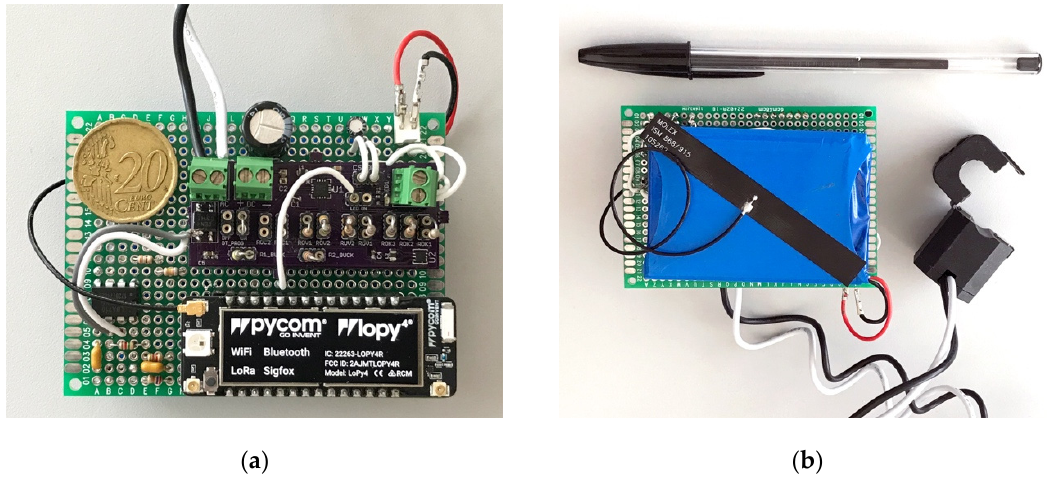
Figure 18. Picture of the prototype: ( a ) Front, where the LoPy4 and the electronic subsystems can be seen; ( b ) back, where the battery, antenna, and clamp inductor are shown.